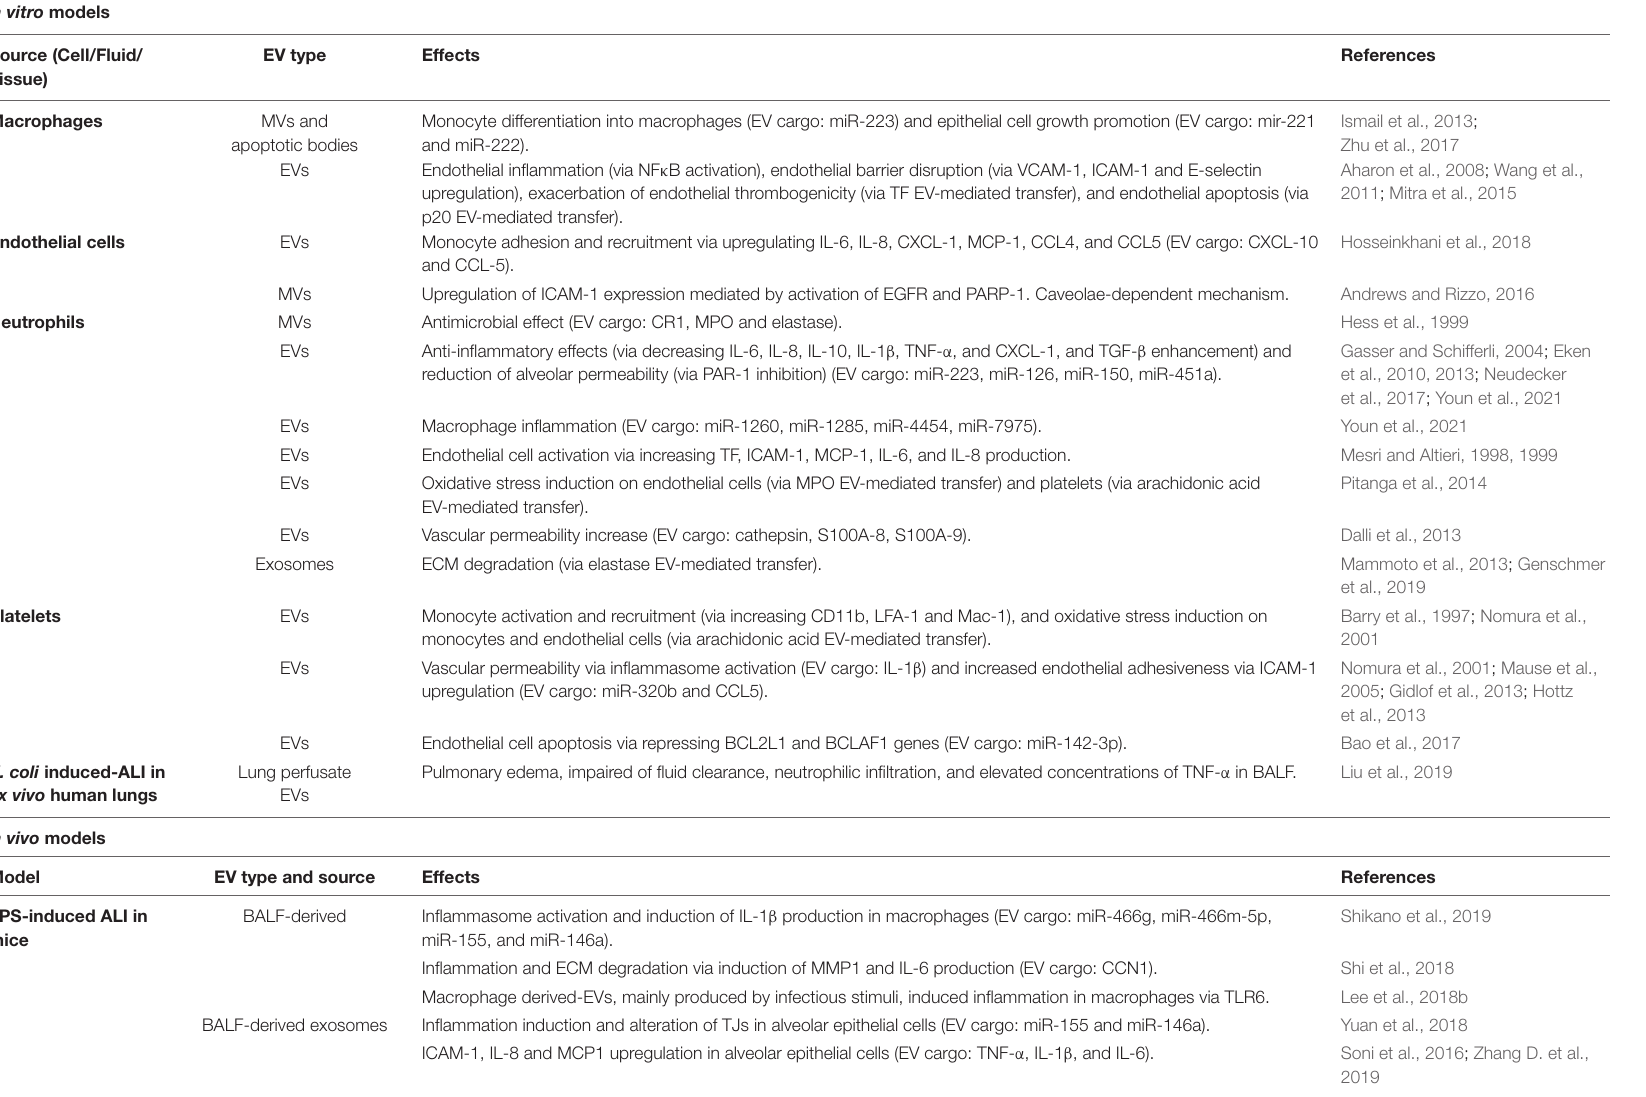
TABLE 2 | Contribution of EVs to the pathogenesis of